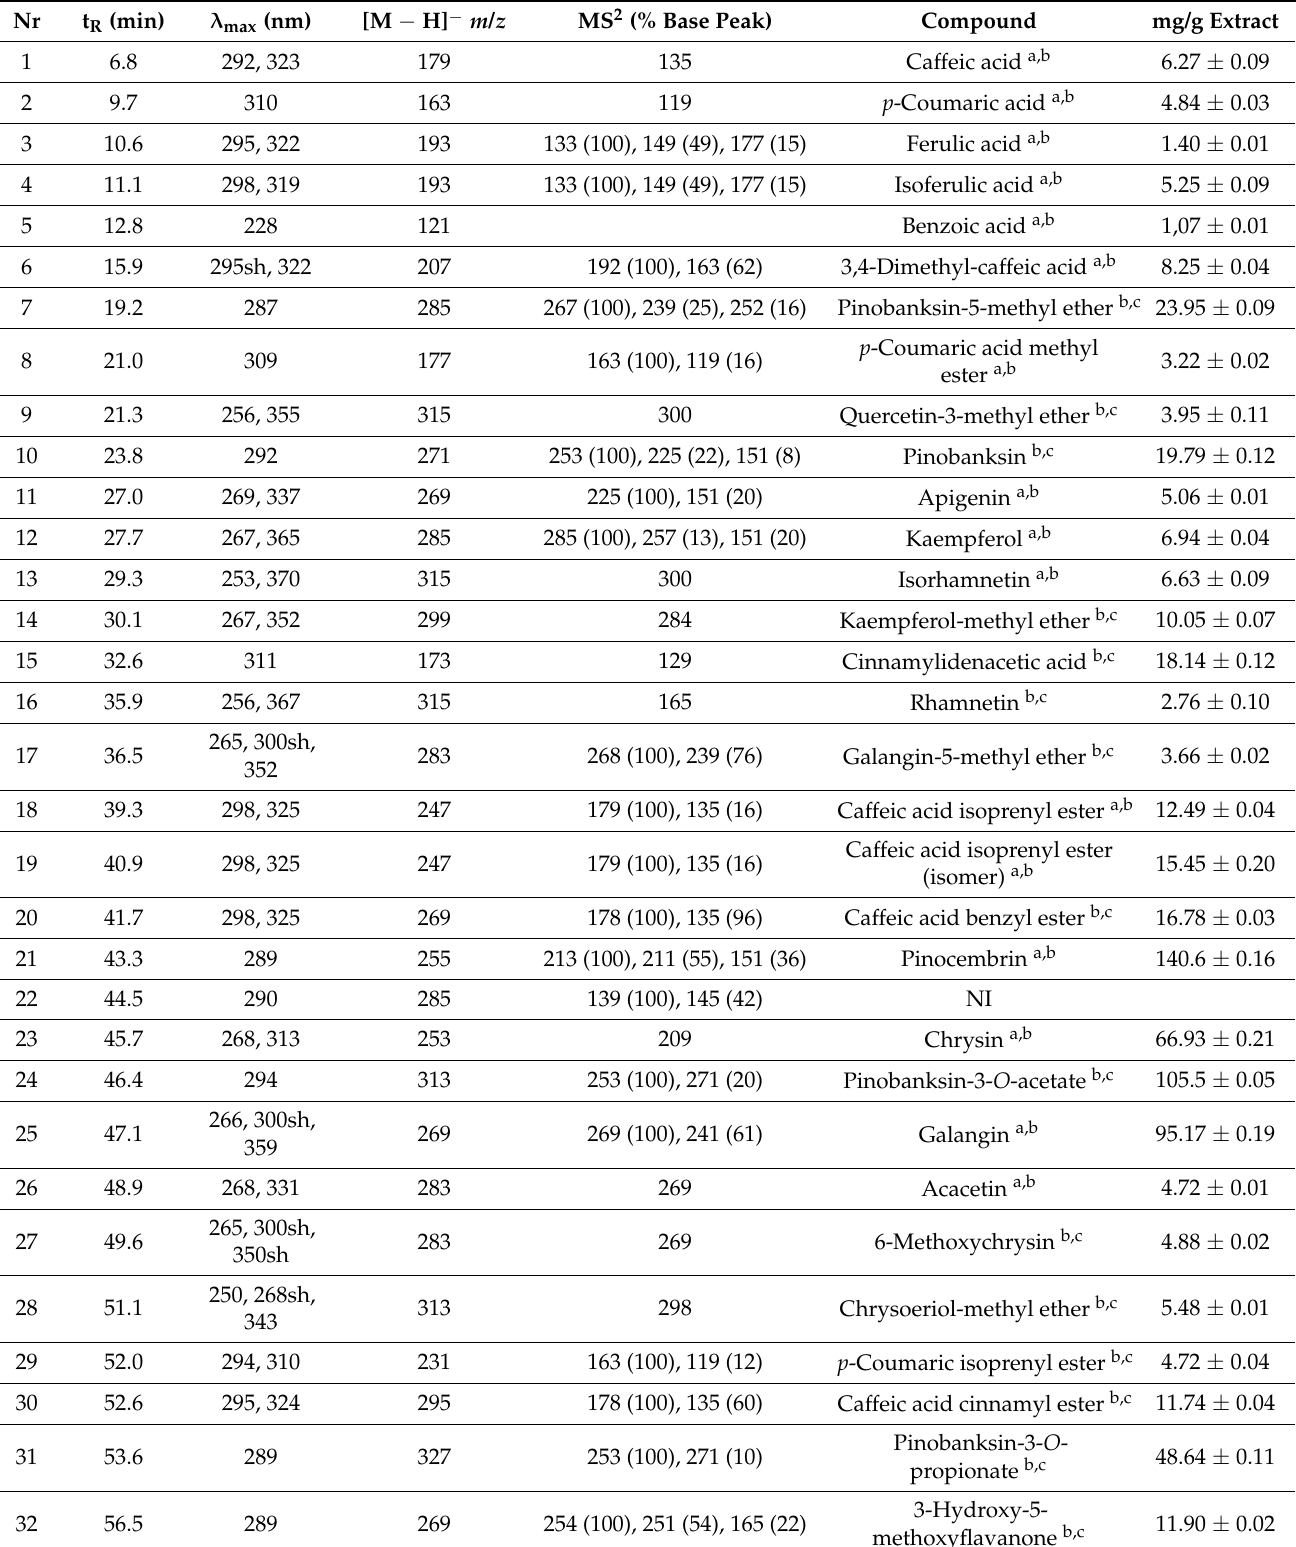
Table 3. Characterization of the phenolic compounds in brown propolis extract, obtained by LC/DAD/ESI-MS n